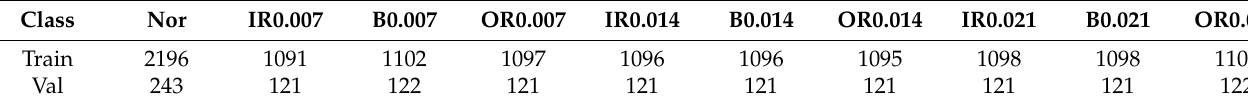
Table 1. Training set and verification set.